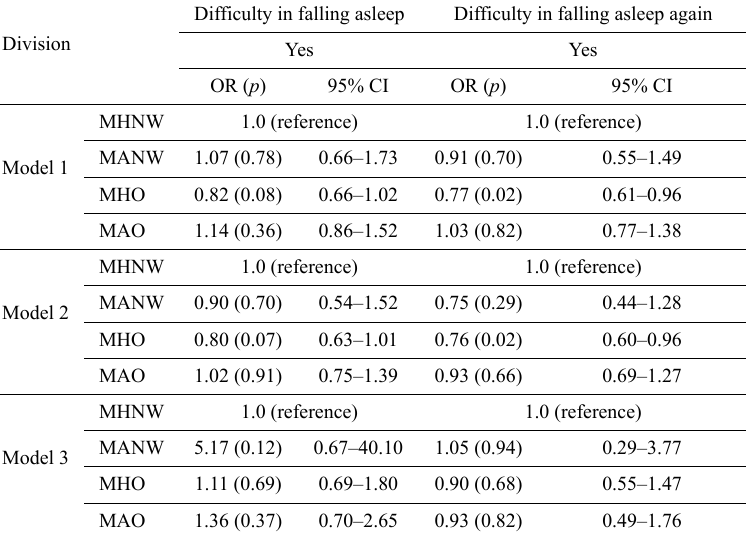
Table 4. Sleep disorder according to the body size phenotypes (n =